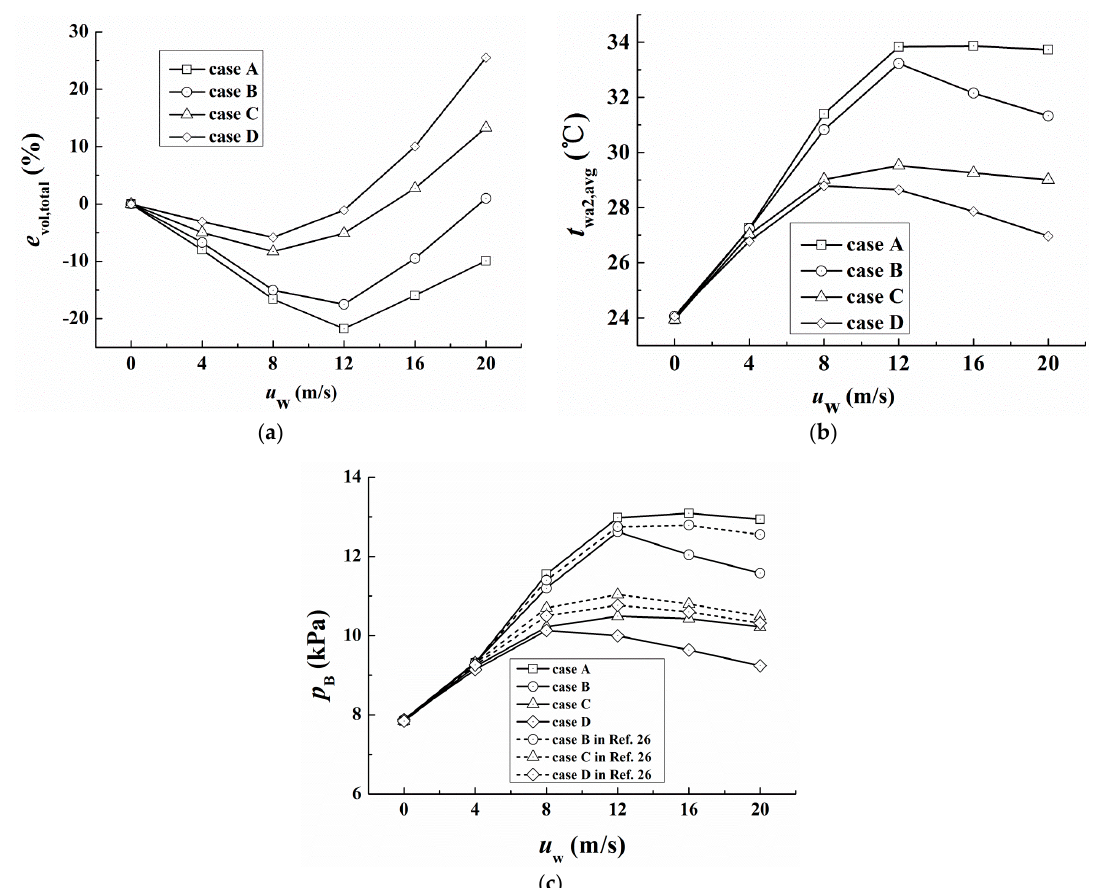
Figure 16. Overall thermo-flow performances of natural draft dry cooling system with air leading strategies. ( a ) Overall volume effectiveness; ( b ) Average outlet water temperature; ( c ) Turbine back pressure.